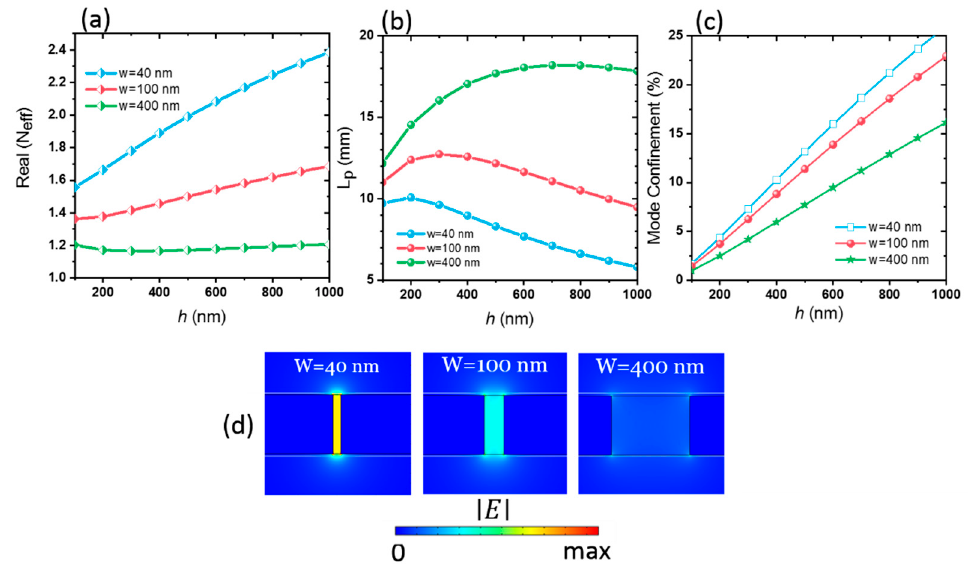
Figure 2. ( a ) Real part of the mode effective refractive index ( N eff ), ( b ) propagation length ( L p ), and ( c ) mode confinement of BSCCO THz plasmonic waveguide as a function of BSCCO thickness h for three slot widths of w = 40, 100, and 400 nm at f = 0.1 THz and T = 10 K. ( d ) Electric field distribution at slot widths of w = 40, 100, and 400 nm for BSCCO height h = 300 nm. All field distributions curves have the same color bar.